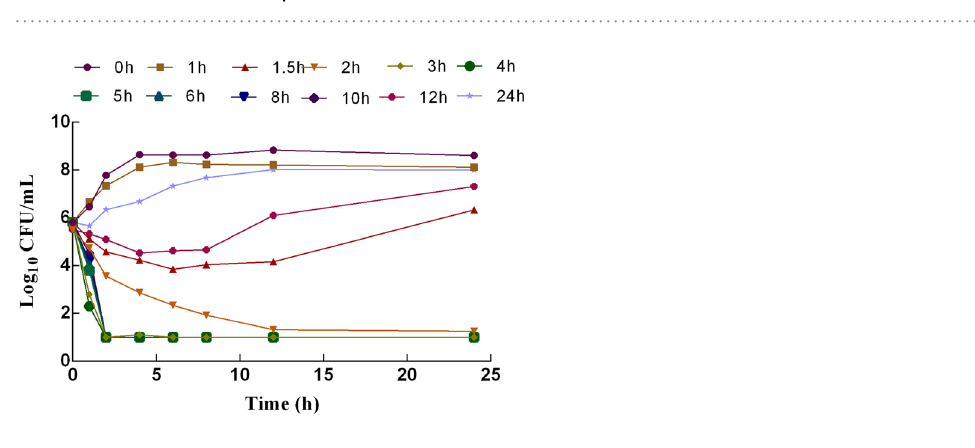
Figure 4. Ex vivo killing curves of cyadox in ileum fluid against C . perfringens CPFK122995 (mean, n = 3). SEM bars not shown for